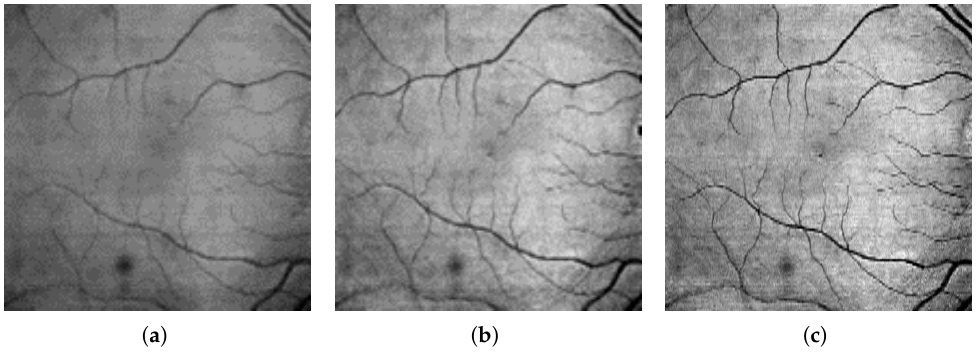
Figure 4. Example of resulting fundus reconstruction images using various retina regions: ( a ) P1— reconstruction from OS+RPE layers, ( b ) P2—reconstruction from GCL and OS+RPE layers, ( c ) P3—fundus reconstruction from GCL+IPL and OS+RPE layers.